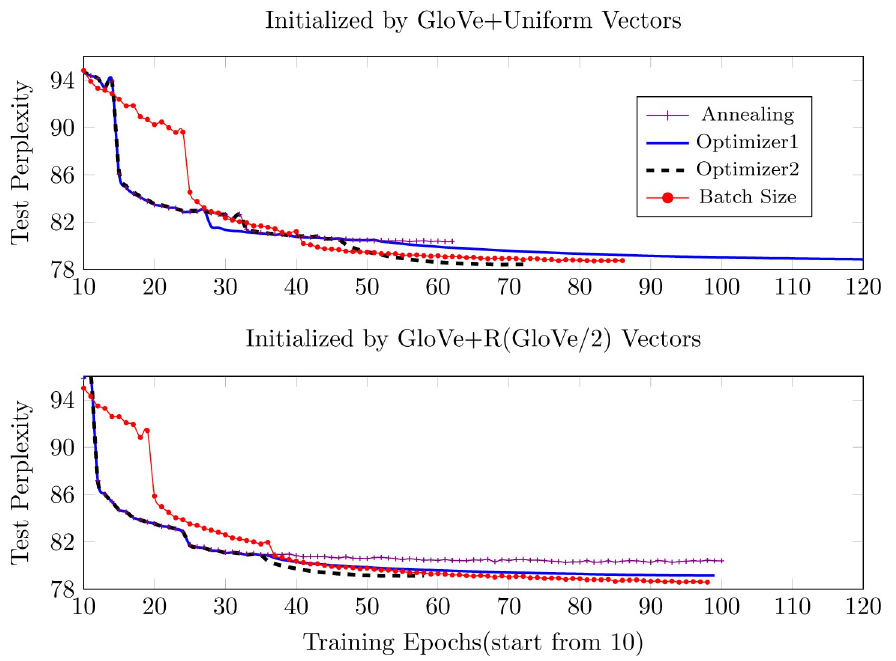
Fig 7. Test perplexity when initialized by precise GloVe vectors.